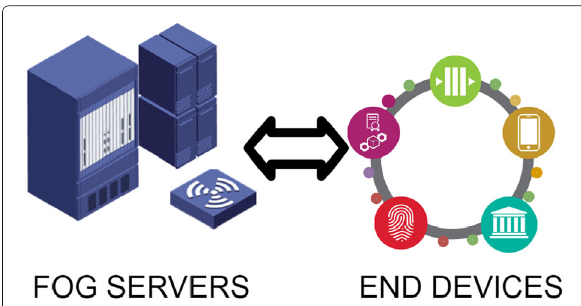
Fig. 4 The exchange of data between fog servers and end